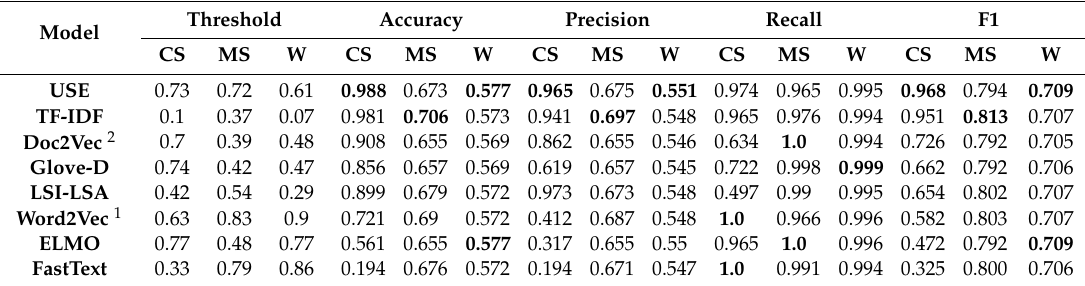
Table 3. Cosine similarity evaluation for models at their best thresholds.